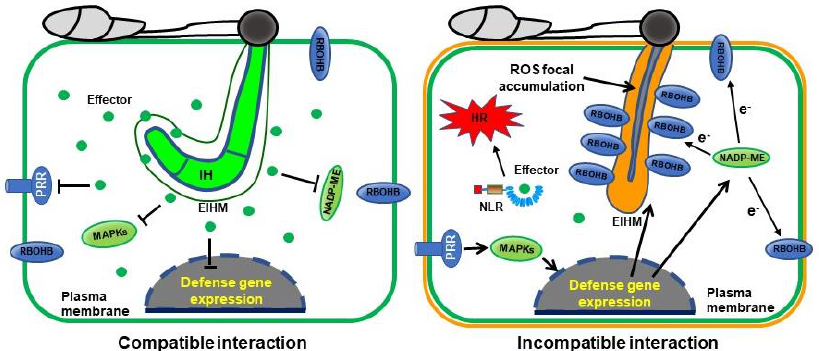
Figure 6. Model of ROS focal accumulation – mediated suppression on hyphal invasion and effector expression and secretion in rice – P. oryzae incompatible interactions. In compatible rice – P. oryzae interactions, invasive hyphae secrete effectors into the rice cytoplasm to interfere with PRR, MAPK cascades, and OsNADP-ME and OsRBOHB activities. Suppressed OsNADP-ME does not supply electron (e – ) to OsRBOHB, which function in ROS production. However, OsRBOHB is strongly expressed, and many OsRBOHB localize around the invasive hyphae and produce considerable ROS (brown color) during avirulent P. oryzae infection. This ROS focal accumulation effectively inhibits invasive hyphal growth and some effector expression and secretion. Effector secretion is blocked in incompatible interactions, but the rarely leaked effectors are recognized by NLR and induce strong HR cell death to eliminate pathogens. PRR, pattern recognition receptors; NLR, nucleotide binding leucine-rich repeat; EIHM, extra invasive hyphal membrane; IH, invasive hyphae.